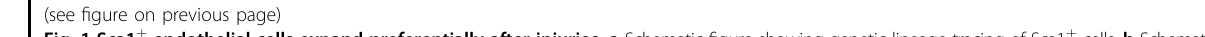
(Fig. 1r). Immunostaining for GFP and VE-Cad on tissue